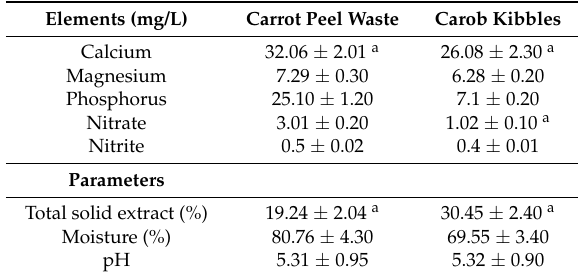
Table 1. Mineral contents and physico-chemical properties of carrot peel waste and carob kibbles